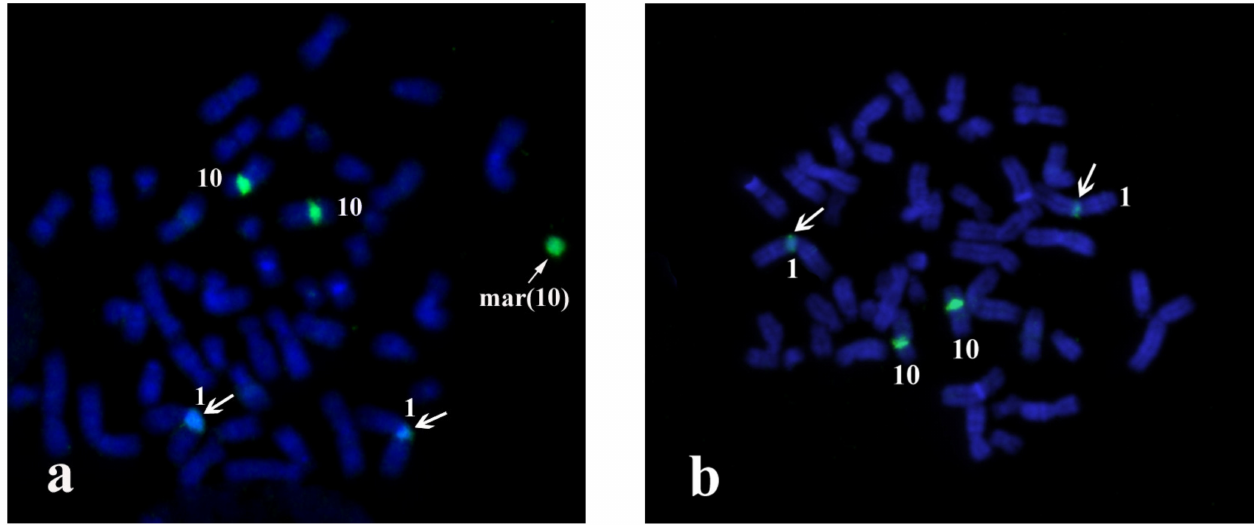
Figure 2. Painting patterns for WCPmar. ( a ) Foetus chromosomes; ( b ) healthy donor chromosomes. Chromosomes 1 (1), 10 (10) and sSMC(mar(10)) are marked; → indicates a signal on the C-region of the q-arm of chromosome 1; → indicates a signal on the sSMC. Chromosomes are stained with